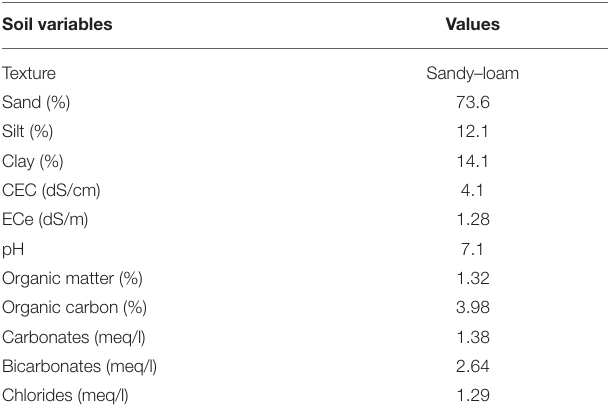
TABLE 1 | Physical and chemical properties of soil used in the